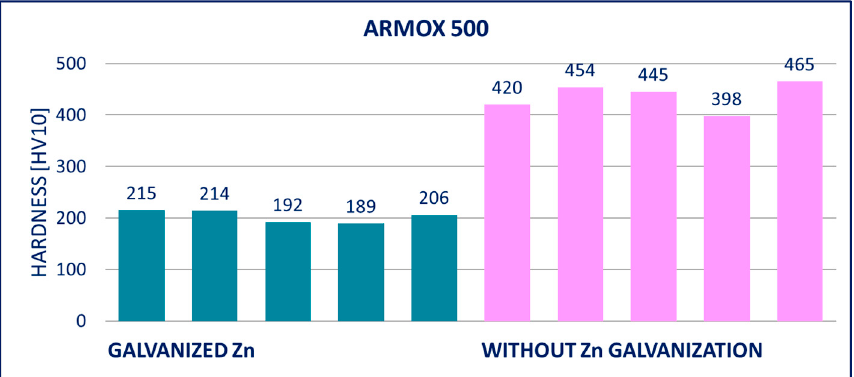
Figure 16. Results of hardness HV10 of specimens of ARMOX 500 steel.